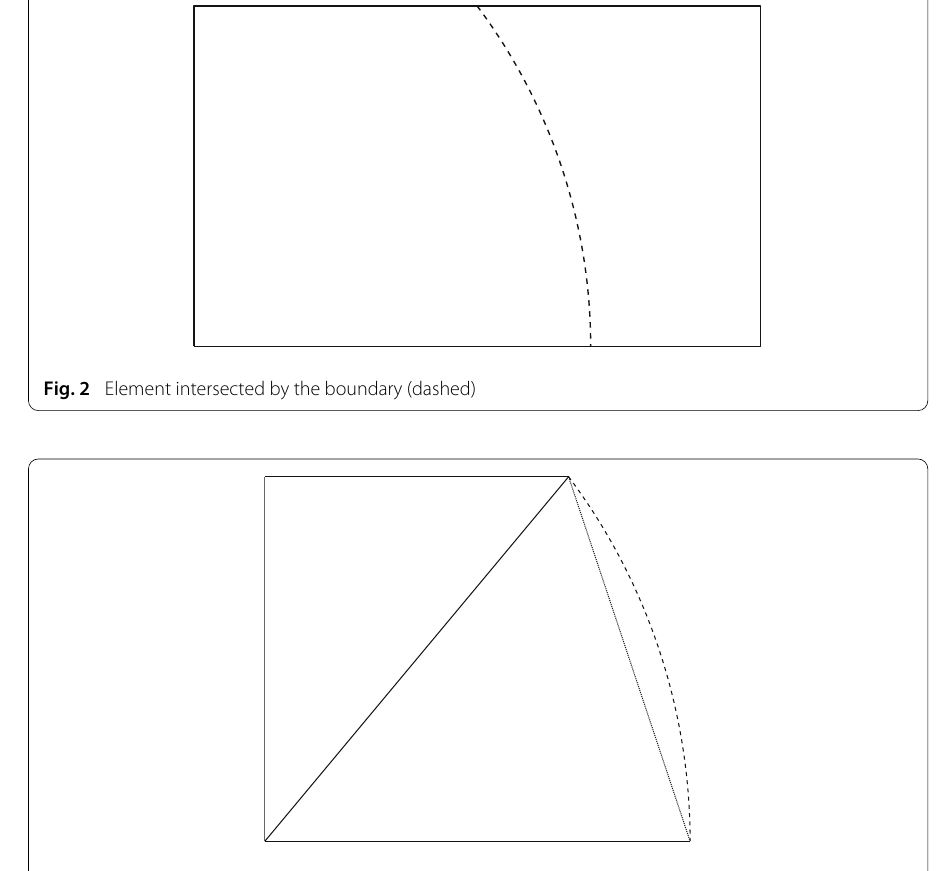
Fig. 3 Straight line approximation of the boundary (dotted) and triangulation for integration purposes